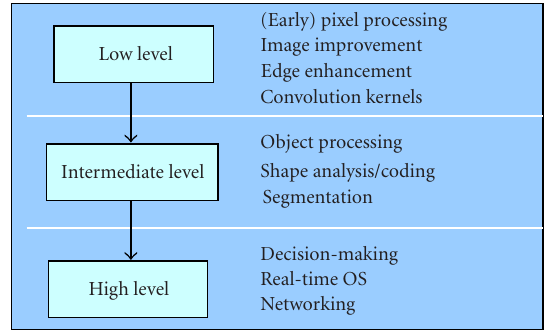
Figure 1: Algorithm classification with respect to the type of oper- ations.